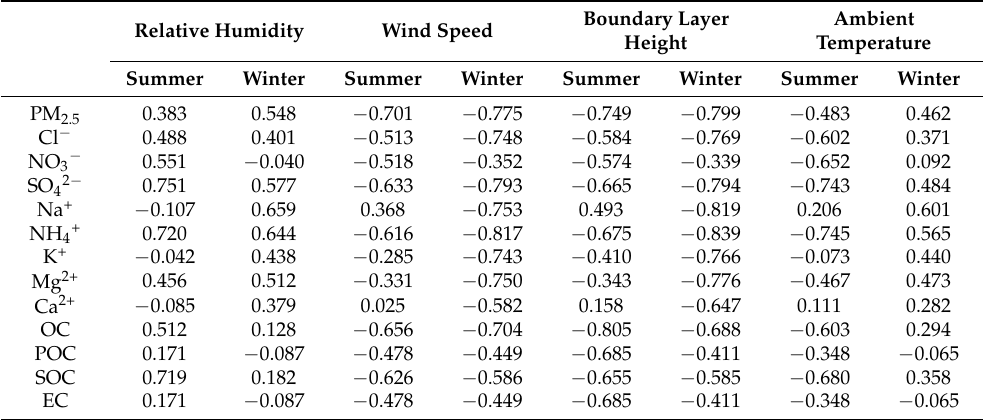
Table 4. Pearson correlation coefficients among PM 2.5 , PM 2.5 chemical compositions, and meteoro- logical